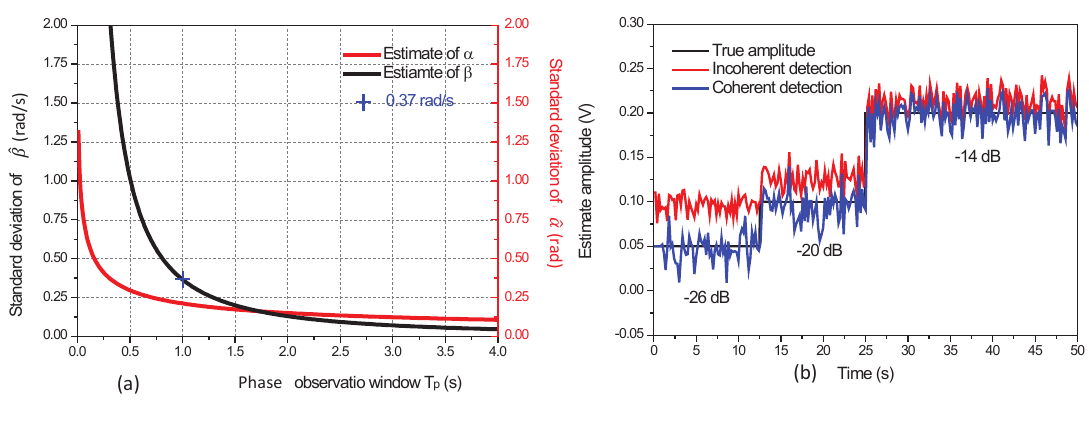
Figure 5. ( a ) Standard deviation of ˆ β and ˆ α for a SNR of − 22 dB; ( b ) Example of LIA detection using coherent and incoherent